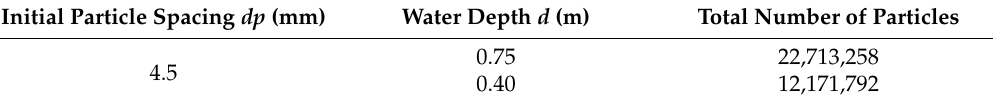
Table 8. Particle spacing and the total number of particles in 3-D.